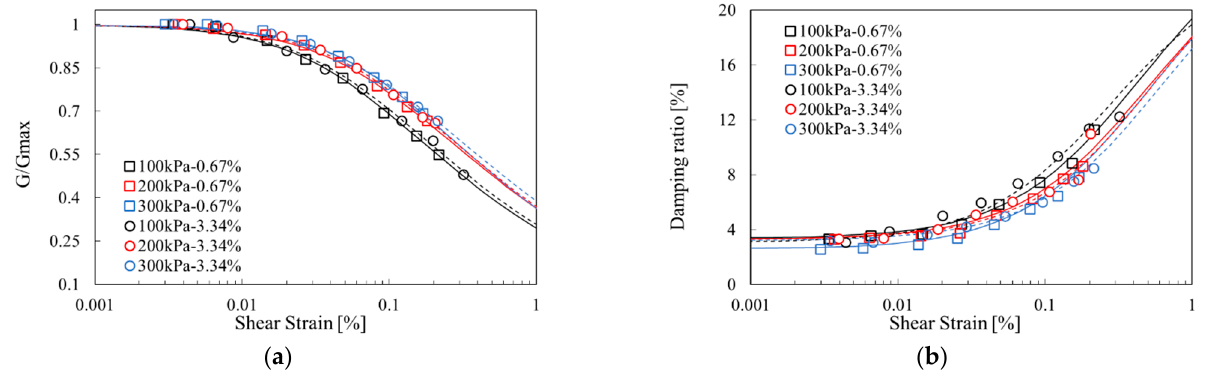
Figure 8. Effects of confining pressure on normalized shear modulus damping ratio: ( a ) relations between normalized shear modulus G/G max and shear strain, ( b ) relations between damping ratio and shear strain .